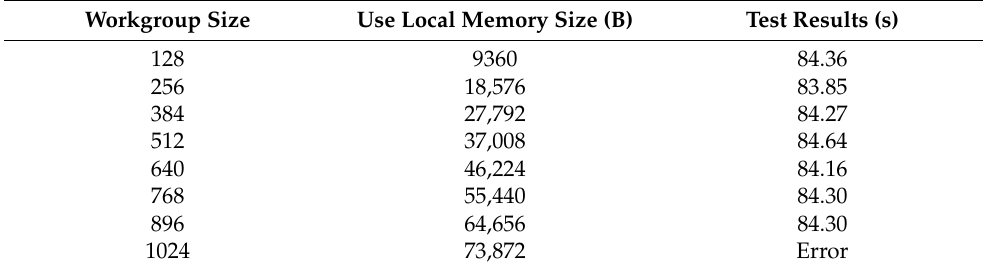
Table 3. Comparison of test results for different workgroup sizes.